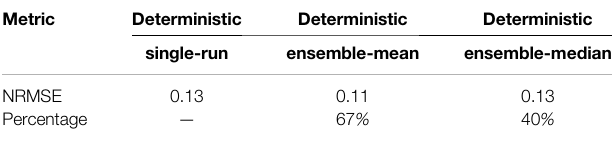
TABLE 6 | Validation of the April 22, 2015 Calbuco simulations with deposit thicknessatscattereddepositpoints.Percentagemeansthefractionofpoints that reducedifferences with observations with respect to the reference single-run. Best values highlighted in